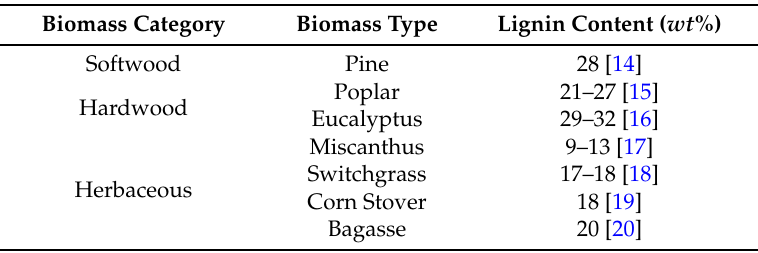
Table 1. Lignin content in lignocellulosic crops.